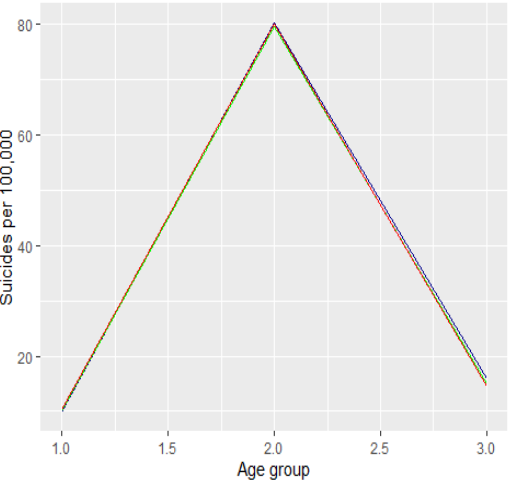
Figure 5. The number of suicides per 100,000 in Poland between 2019 and 2021.